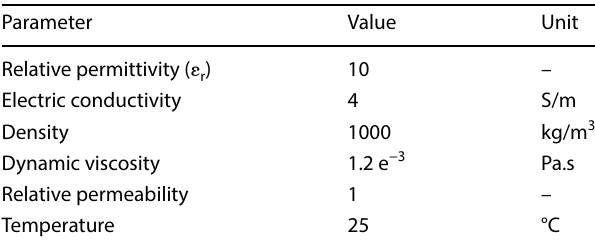
Table 1 NaOH characteristics